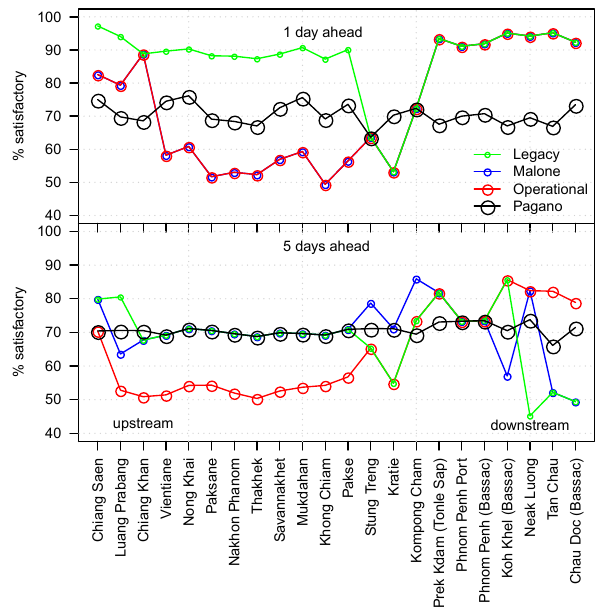
Figure 4. Percentage satisfactory for 1- (top) and 5 (bottom)-day wet-season forecasts by location. Forecasts are evaluated using four different benchmarks (colored lines). The benchmark proposed by this study (black line with large circles) is defined to give a 70% satisfactory rate over the long term; deviations from 70% are due to the rounding of the benchmark